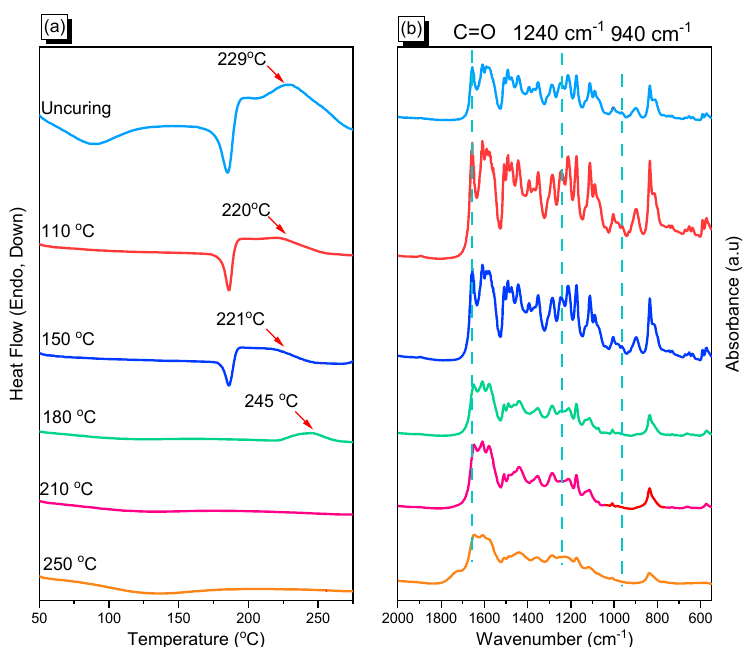
Figure 2 . ( a ) DSC and ( b ) in situ FTIR spectral analyses of the uncured PA-BZ and the PA-BZ thermally polymerized at various curing temperatures to form poly(PA-BZ).